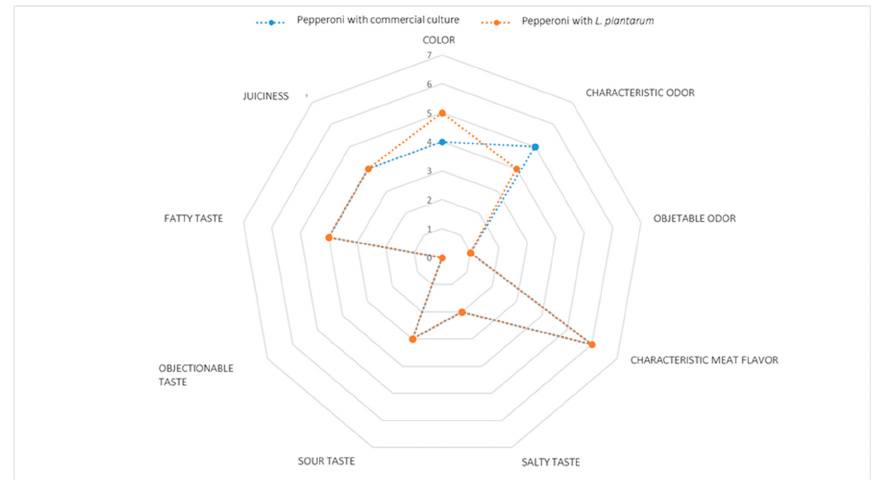
Figure 3 . Sensory profile of pepperoni prepared with commercial culture vs. pepperoni with L. plantarum propagated at bench scale.